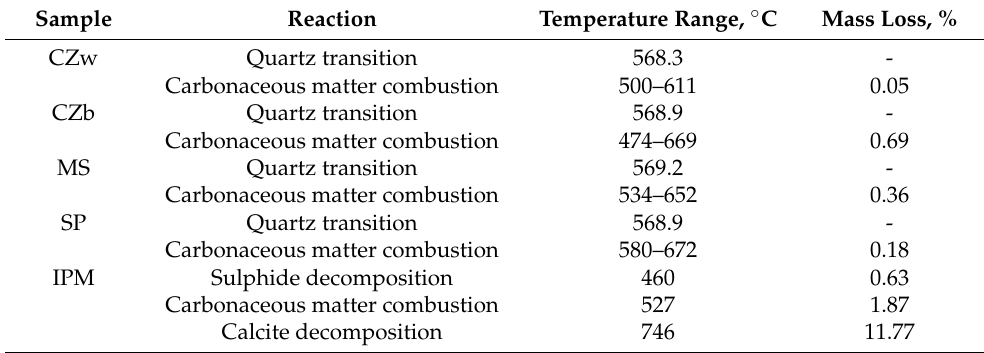
Table 1. TG and DSC results for the black agates from the ZF of the Onega Basin.